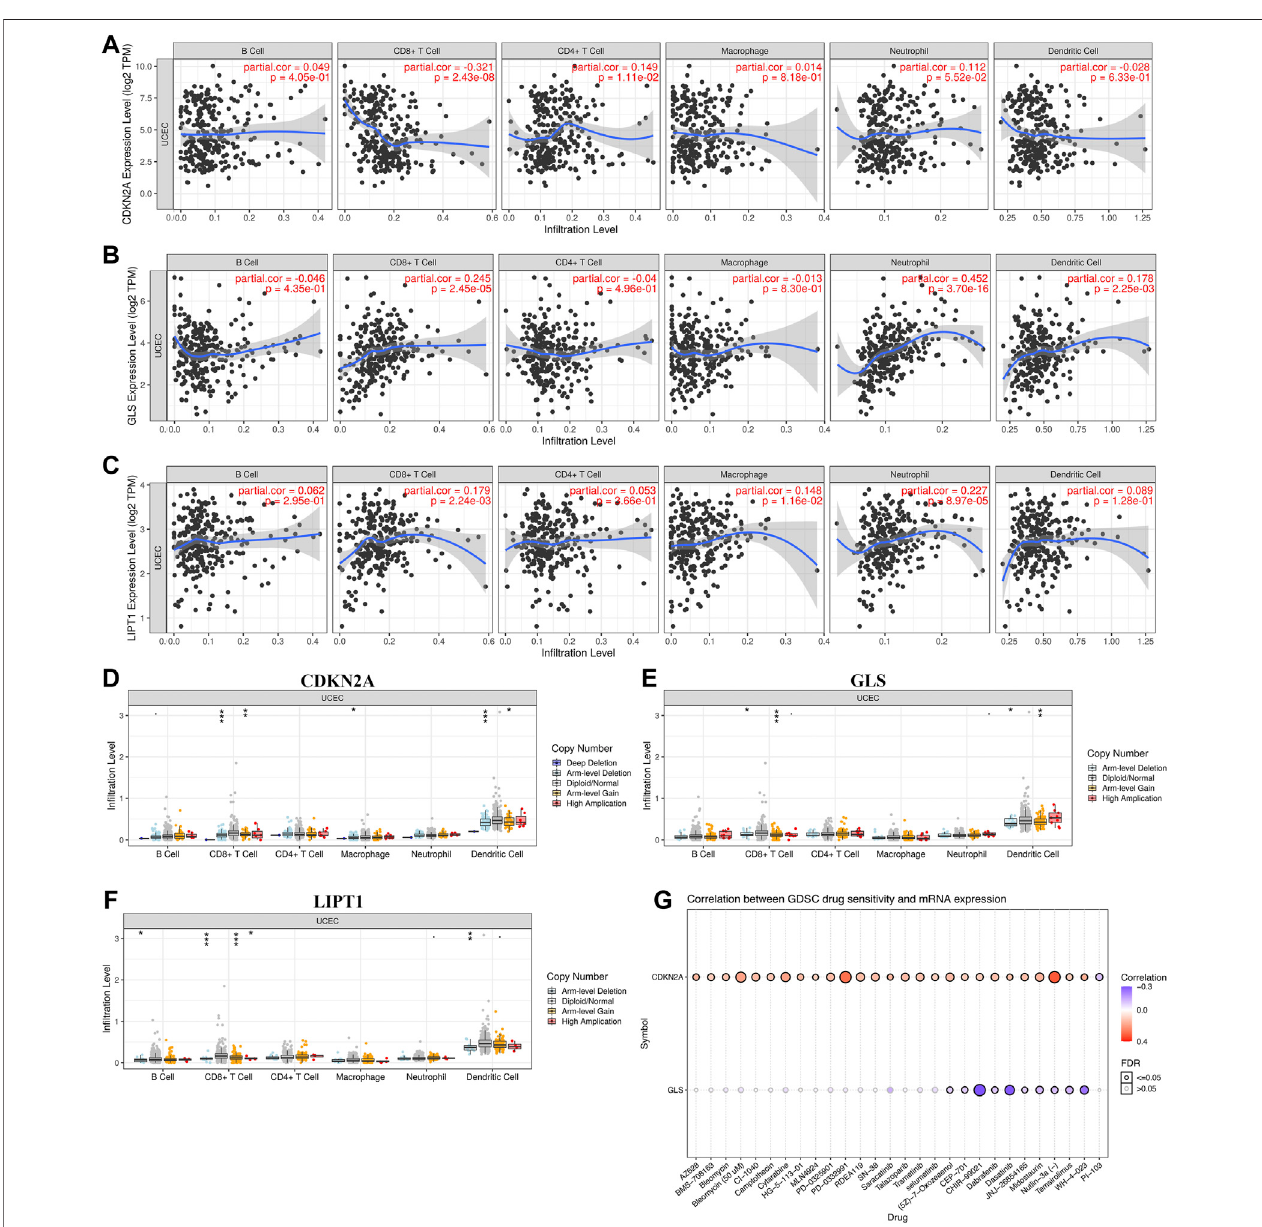
FIGURE 8 | Immune cell in fi ltration and drug sensitivity analysis of cuproptosis-related prognostic biomarkers in uterine corpus endometrial carcinoma (UCEC). (A – C) Correlation between the expression of CDKN2A, GLS, and LIPT1 and immune cell in fi ltration in UCEC. (D – F) Correlation between copy number variation of CDKN2A, GLS, and LIPT1 and immune cell in fi ltration in UCEC. (G) Correlation between the expression of CDKN2A, GLS, and LIPT1 and drug sensitivity in UCEC. GDSC, genomics of drug sensitivity in